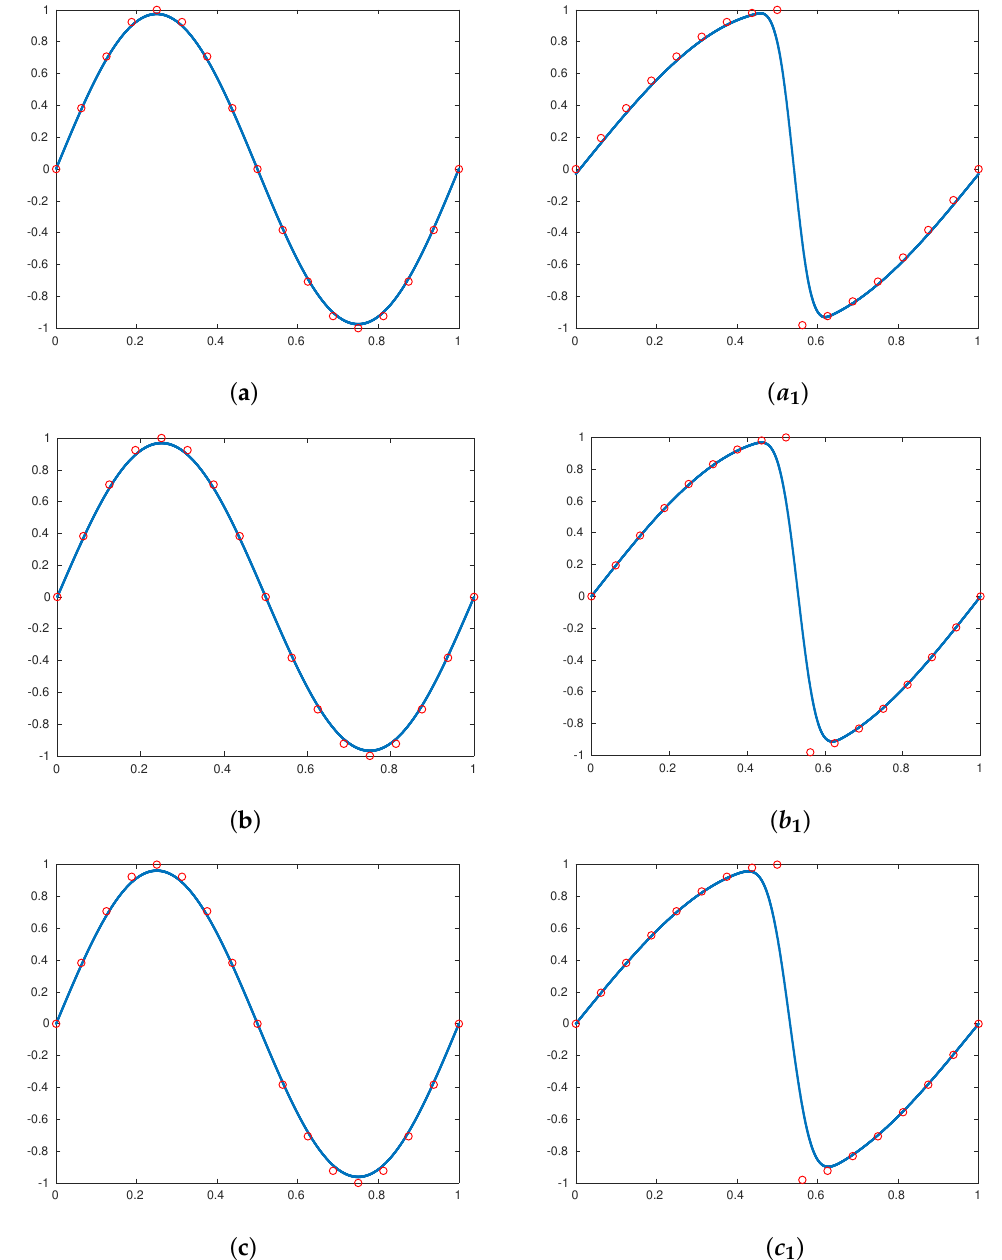
Figure 2. Images on the left were obtained using the continuous function defined in (33), images on the right were obtained using the discontinuous function (34) using five subdivision scales; the results shown in ( a ), (also a 1 ), ( b ), ( also b 1 ), and ( c ), (also c 1 ) were obtained by S 2 (11), S 3 (13), and S 4 (15), respectively, where w = 1 . In this figure, the original sampling is represented in ◦ 3